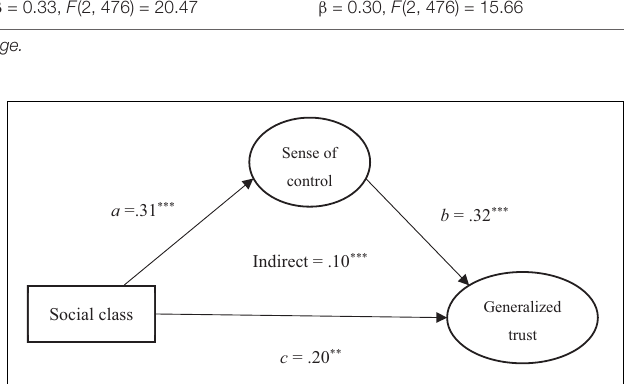
FIGURE 1 | Mediating model illustrating the relationships among social class, sense of control, and generalized trust. Paths a, b, and c represent direct effects. All numbers are standardized regression coefficients. ∗∗ p < 0.01, ∗∗∗ p < 0.001. The 95% confidence interval of the bias-corrected indicates a significant indirect